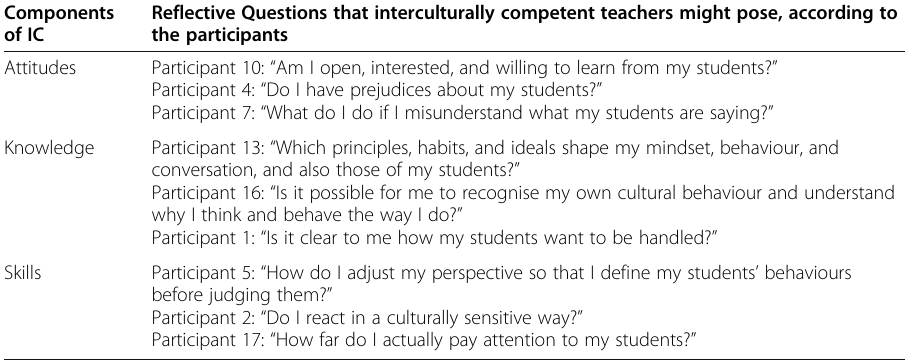
Table 2 Examples of the Fundamental Components of IC Components of